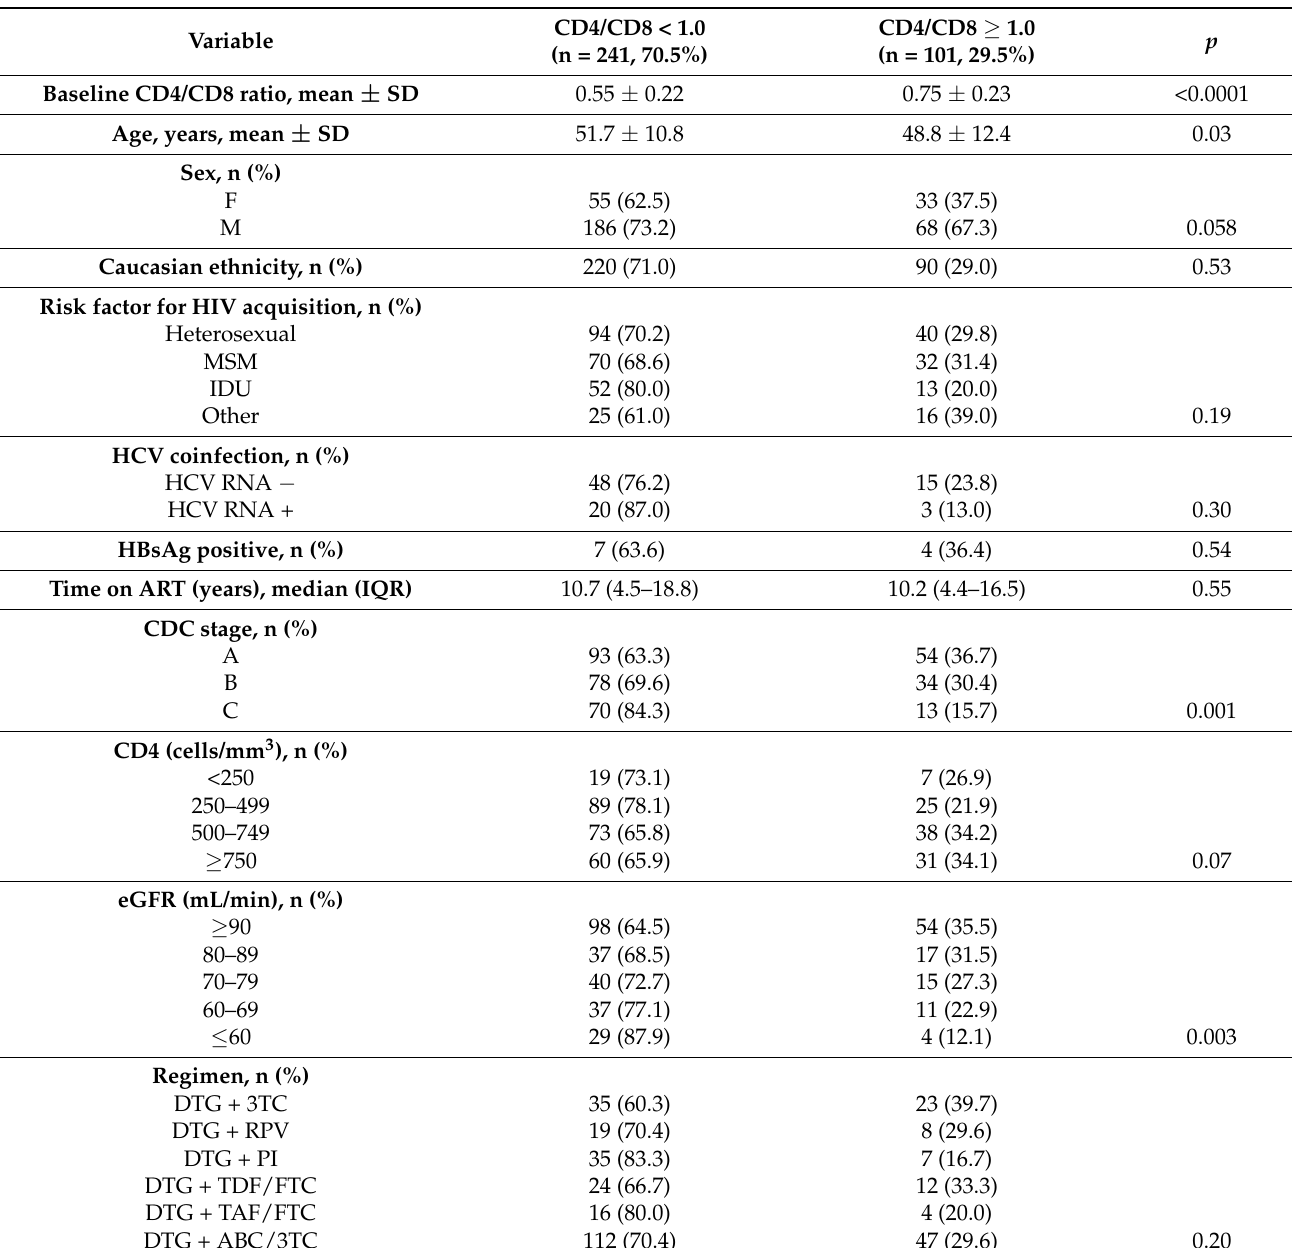
Table 3. Characteristics of 342 study participants with baseline CD4/CD8 < 1.0, according to the achievement of CD4/CD8 ratio ≥ 1.0 during the study